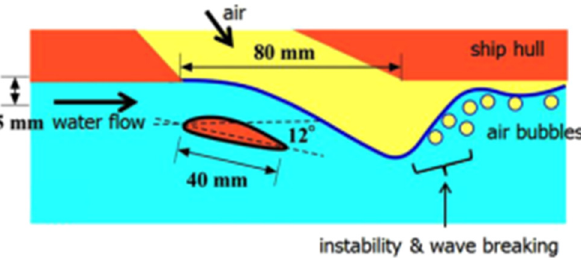
Figure 5. Dimensions and Kelvin–Helmholtz action of the WAIP system. (Reproduced with per- mission from Kumagi, I., Ocean Engineering ; published by Elsevier, 2015.)